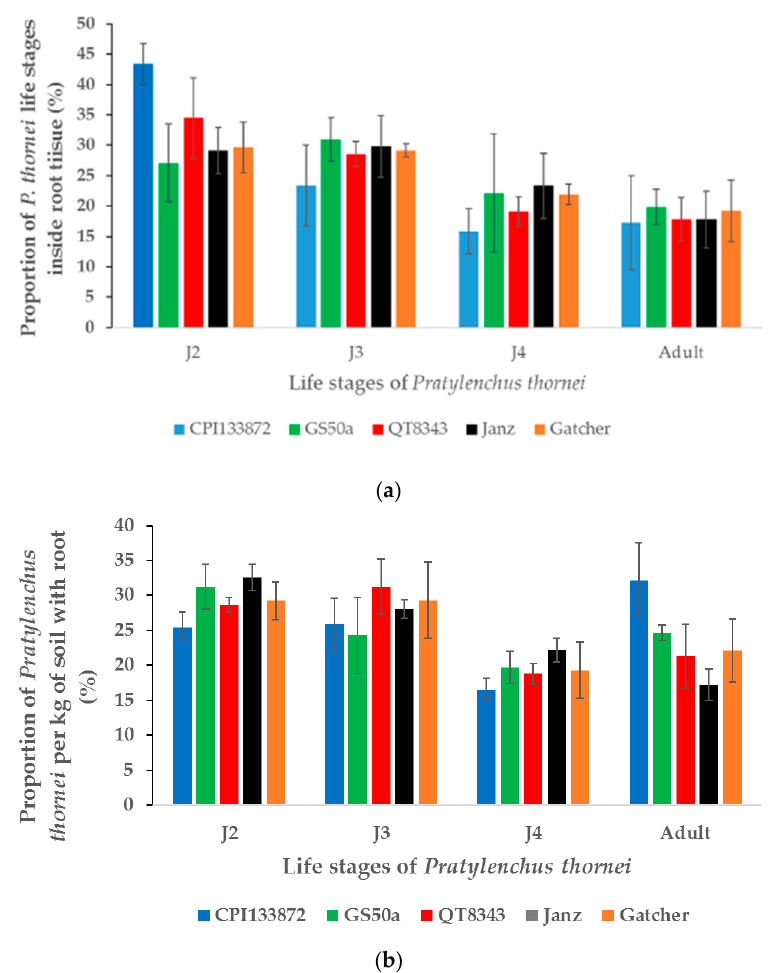
Figure 6. Proportion of Pratylenchus thornei life stages ( a ) inside roots of different wheat genotypes and ( b ) per kg of soil and root. The values are the mean ± standard error.